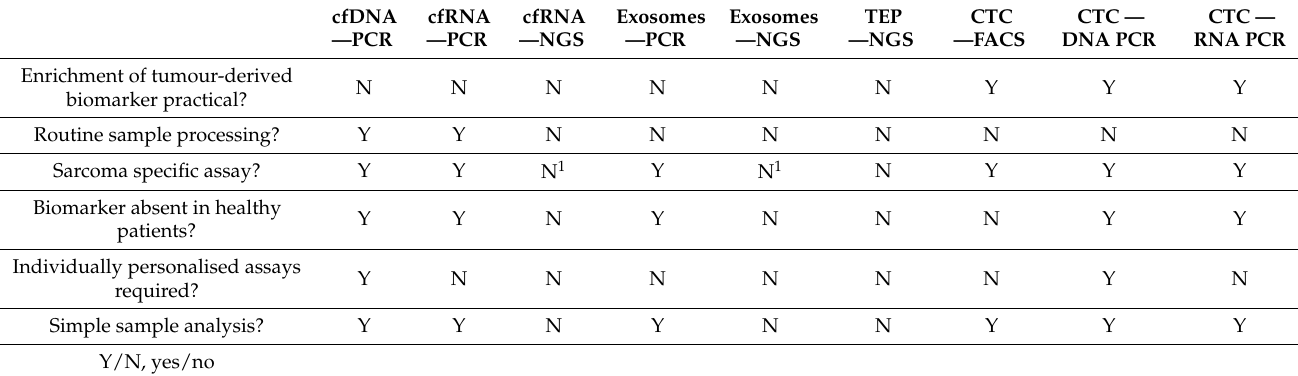
Table 1. Practical considerations for the early detection of relapse of sarcoma by liquid biopsy.